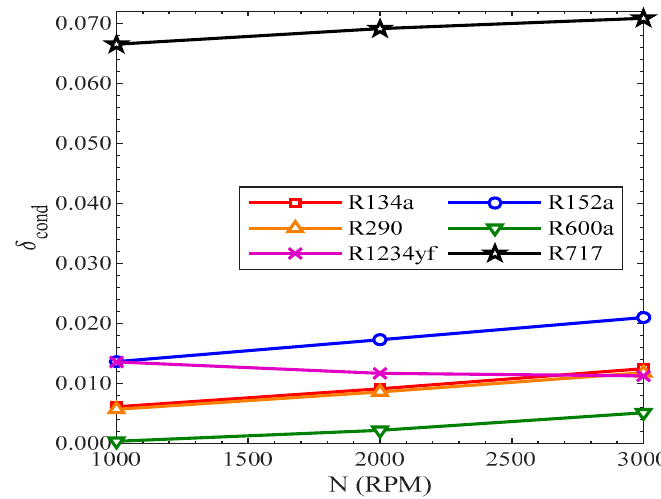
Figure 19 . Efficiency defect of condenser vs. compressor speed .